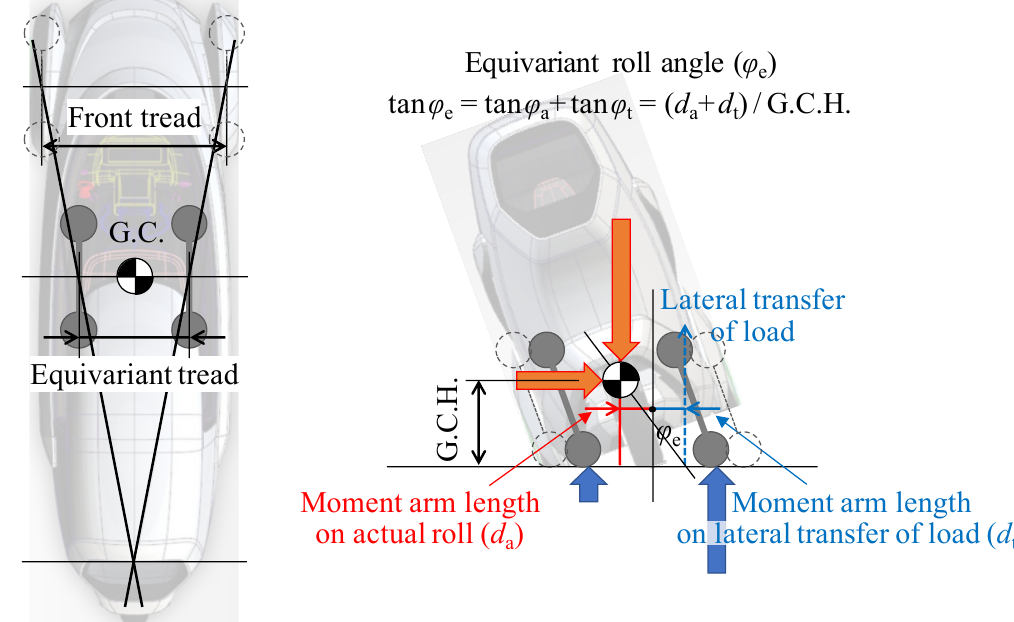
Figure 25. Roll moment balance on PMV with active tilting mechanism.